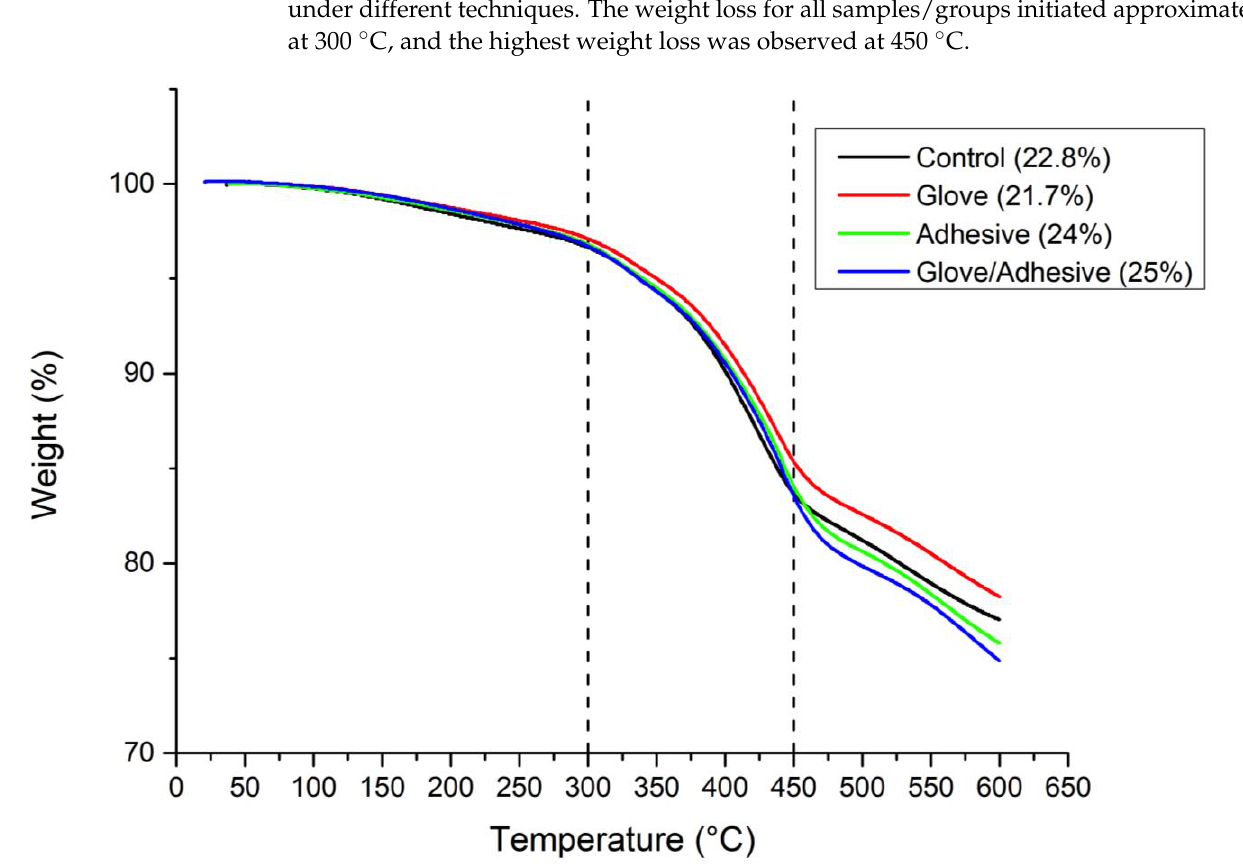
Table 2. Data (mean ± standard deviation) resulting from flexural strength (MPa), modulus of elasticity (Gpa), and fracture toughness (MPa.m 0.5 ) tests for composite resin specimens han- dled/modeled under different techniques (gloved-hands and/or adhesive) *.